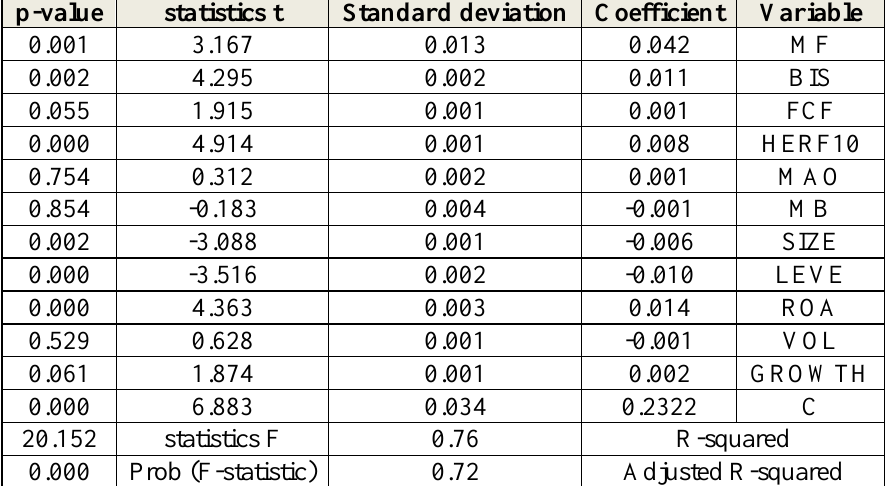
Table 1. Estimation Results of